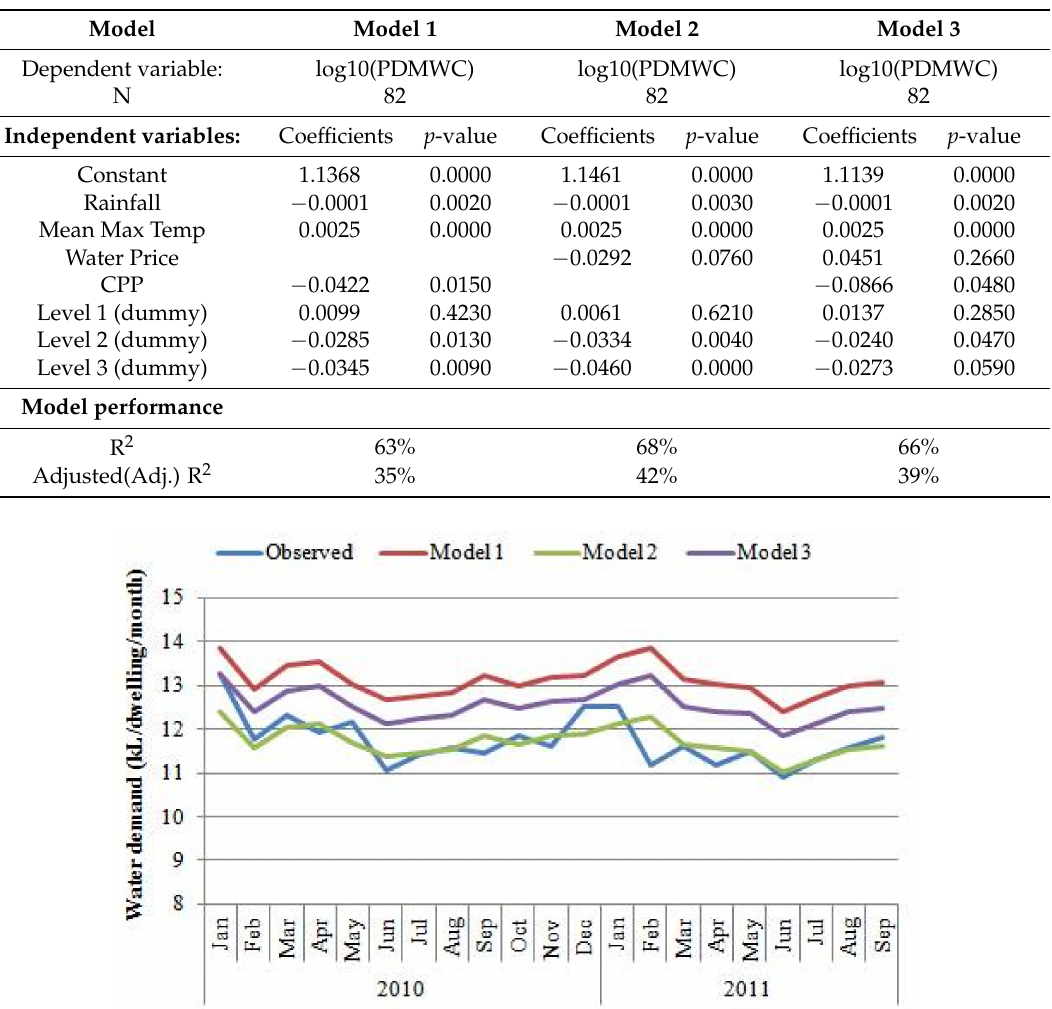
Figure 4. Simulation results by Models 1, 2 and 3 for the period of 10 January–11